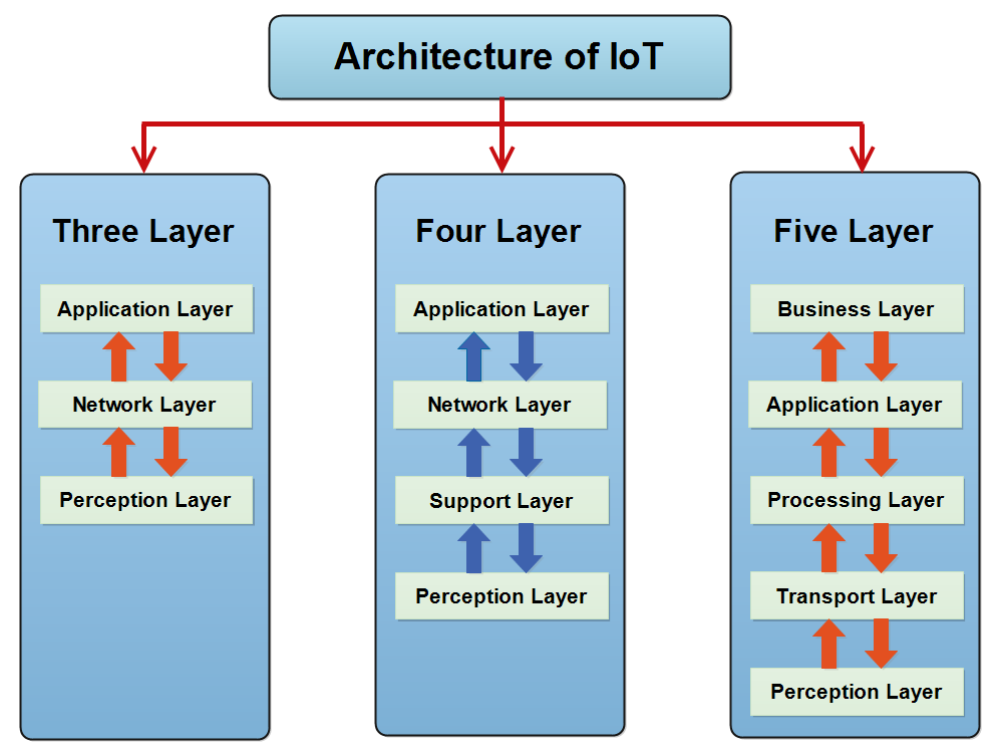
Figure 6. The layered architectures of IoT (three, four and five